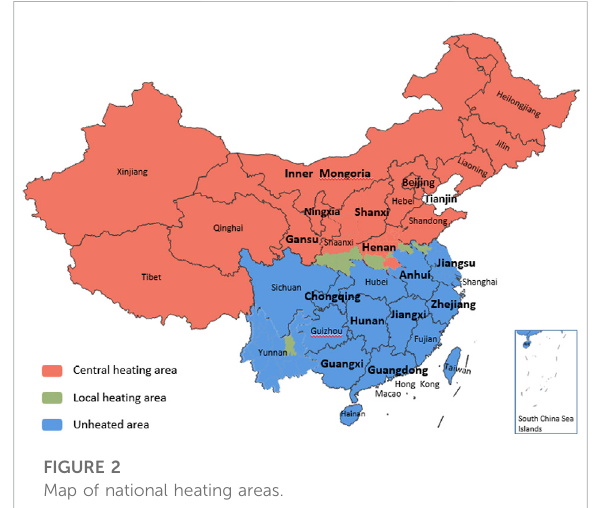
FIGURE 2 Map of national heating